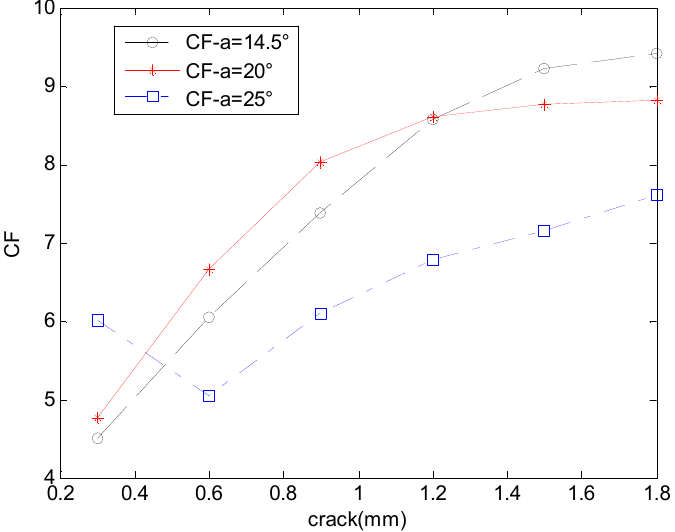
ff erent pressure